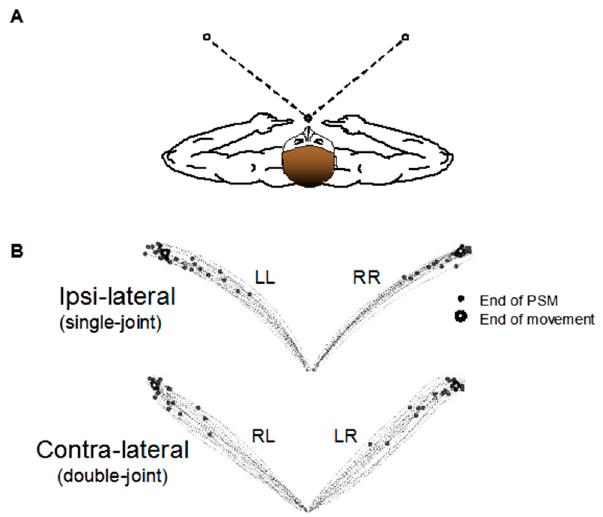
Figure 1. Experimental setup and representative data. ( A ) Participants performed spatially con- strained discrete pointing movements to targets situated on either side of their midline using either their right or left arms. ( B ) Experimental data from one older participant. Endpoint (fingertip) trajectories and primary submovement end for each movement condition from a 68-year-old woman. LL: left hand to left target, RR: right hand to right target, RL: right hand to left target, LR: left hand to right target.